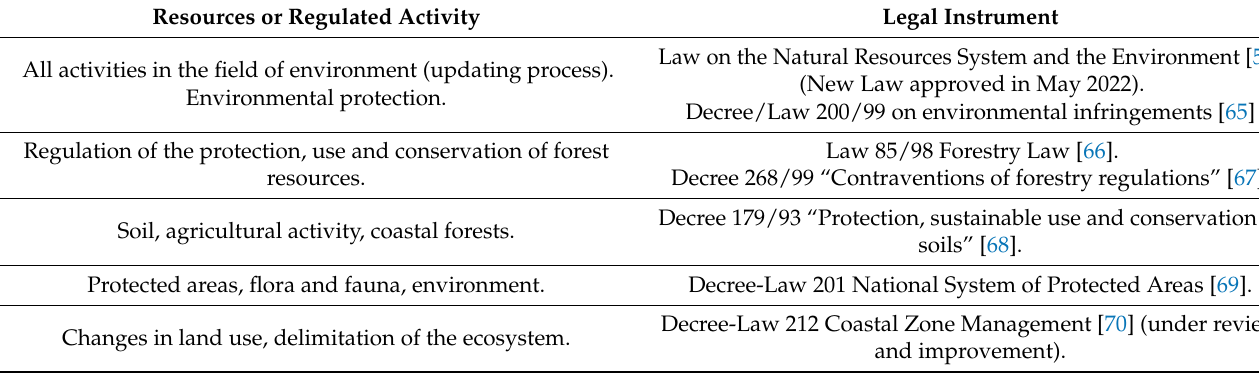
Table 3. Current Cuban legislation allows regulating activities in the mangrove as a